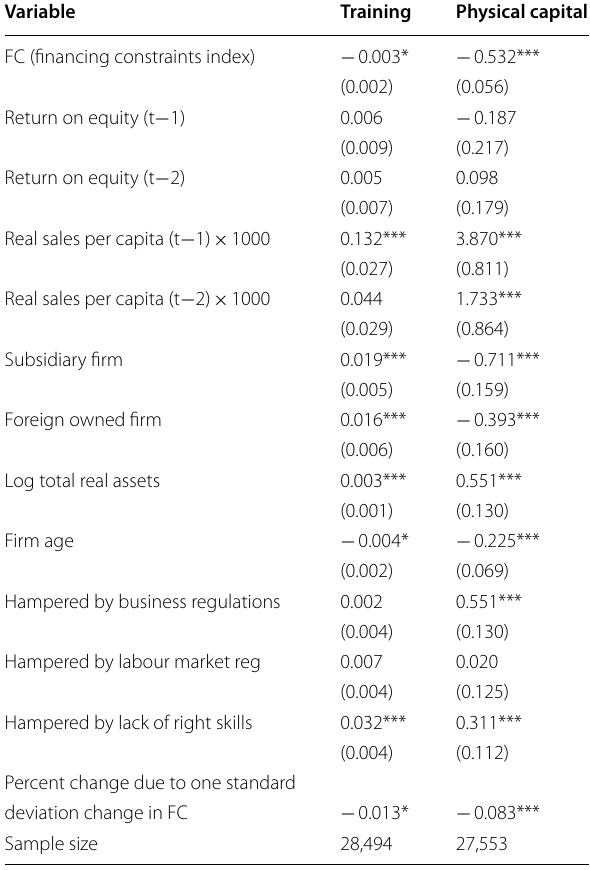
Table 4 The effect of the financing constraints index (FC) on investment in training per employee (TI) and in physical capital per employee (KI). OLS estimates.